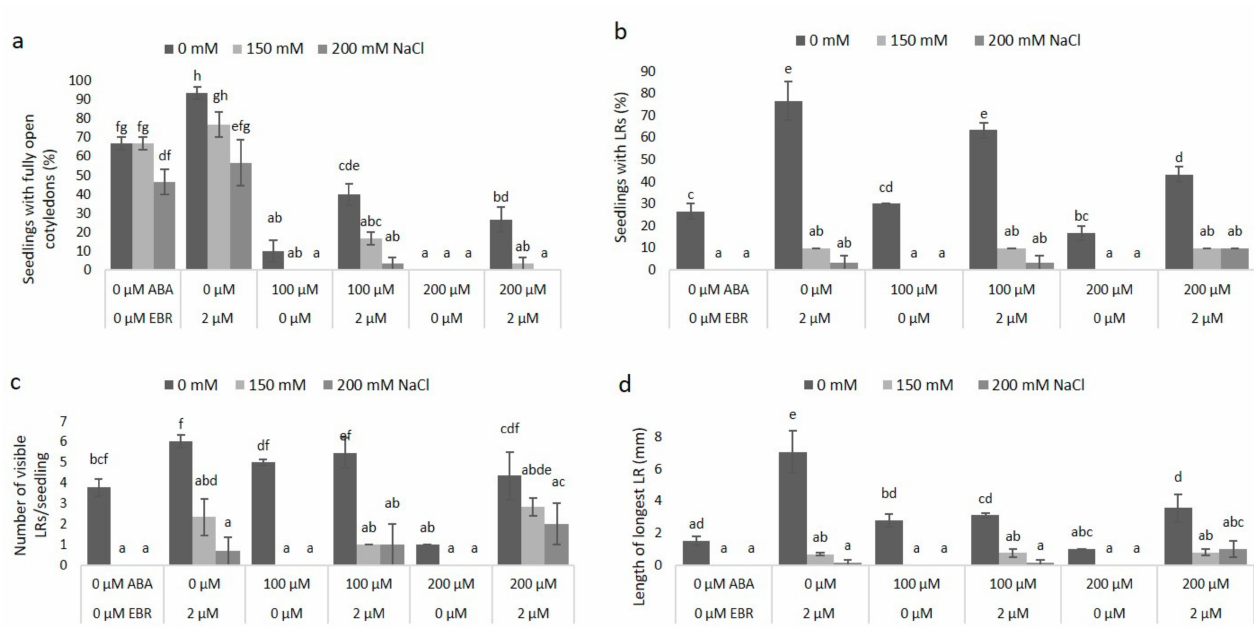
Figure 4. Cotyledon opening and lateral root (LR) formation in seedlings under salt stress following pre-treatment with either EBR or ABA alone or together. Percentage of seedlings with fully open cotyledons ( a ); percentage of seedlings with LRs ( b ); average number of visible LRs per seedling ( c ); average length of the longest LR in seedlings ( d ), in response to pre-treatment with EBR (0 and 2 µ M), ABA (100 and 200 µ M), and ABA + EBR (as indicated in figures) under 0, 100 and 200 mM NaCl were recorded on the 13th day after seeds were put to germination. Error bars represent standard error (SE) of the mean for three replicates ( n = 30). Different letters above the bars indicate significant differences in two-way ANOVA ( p < 0.05) followed by Tukey’s post hoc